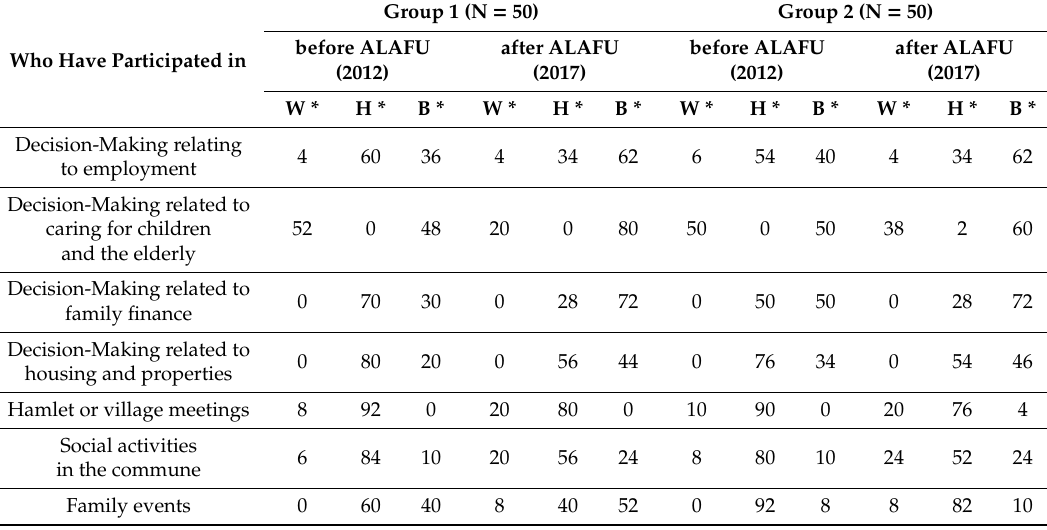
Table 7. Changing the participation in decision-making and social activities (Percentage of household).